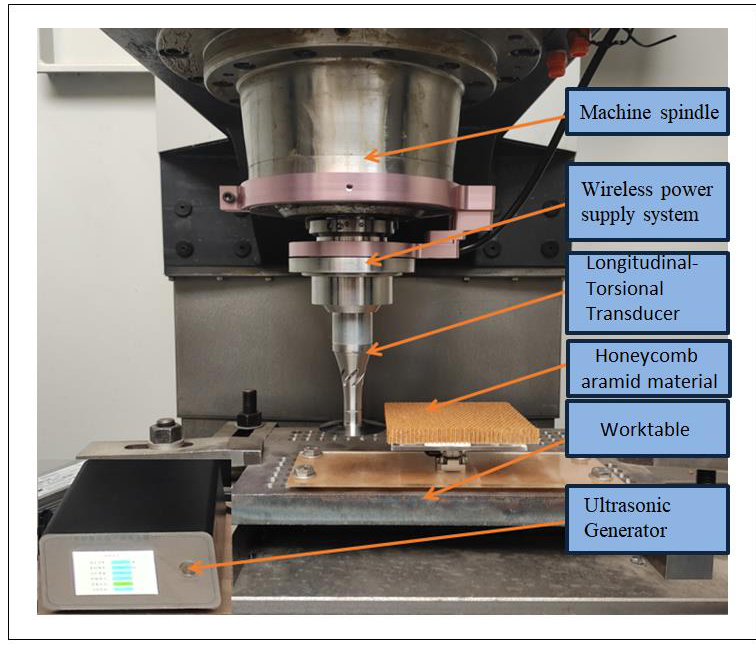
Figure 12. Experimental setup.